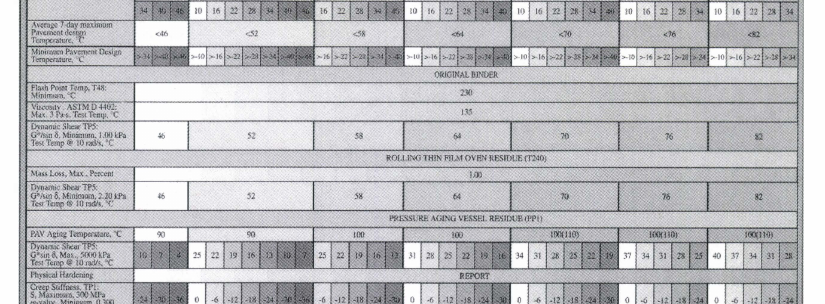
Abb. 3: Die neuen SUPERPAVE· Spezifikationen aus der SHRP-Studie Fig. 3: The New Superpave Bitumen Specification Developed During